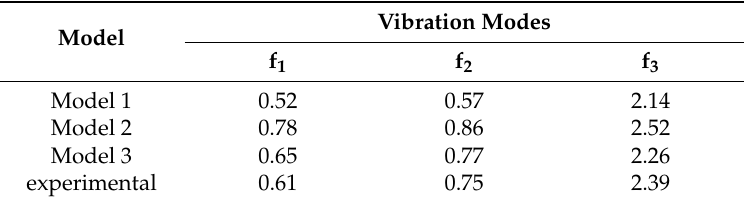
Table 7. Modal analyses results: global